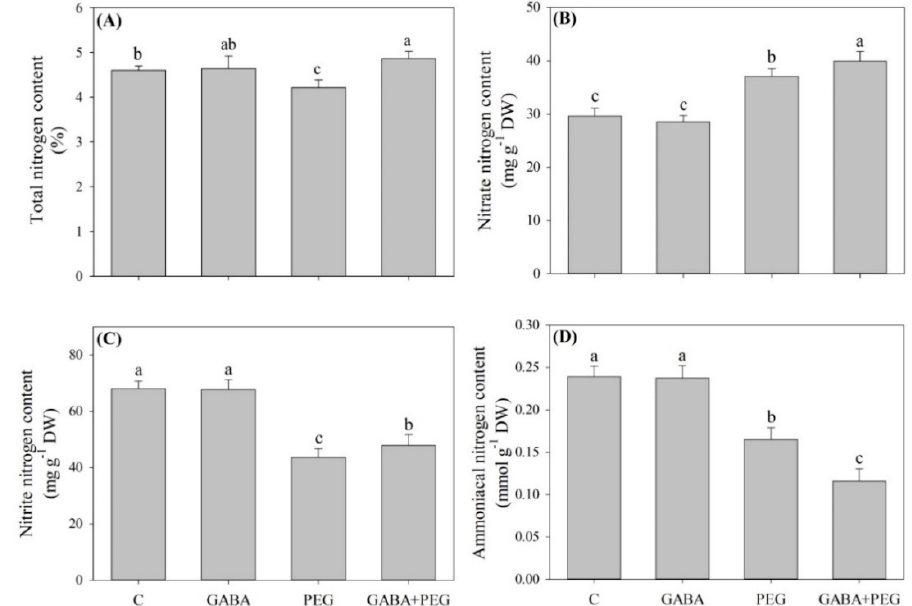
Figure 5. Effects of exogenous γ -aminobutyric acid (GABA) pretreatment on ( A ) total nitrogen content, ( B ) nitrate nitrogen content, ( C ) nitrite nitrogen content and ( D ) ammoniacal nitrogen content in leaves of creeping bentgrass under non-stress and water stress conditions. Vertical bars indicate ± SE of mean ( n = 4). Different letters above columns indicate significant difference based on the LSD ( P ≤ 0.05). C, well-watered control; GABA, well-watered control pretreated with GABA; PEG, PEG-induced water stress; GABA + PEG, water-stressed plants pretreated with GABA.